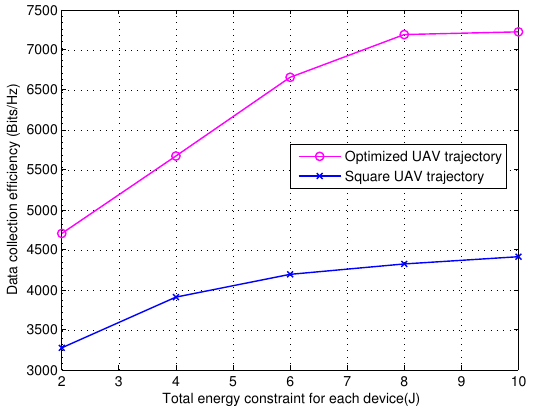
Figure 3. Comparison of data collection efficiency versus total energy constraint of each device for the optimized trajectory and square deployment, both with the aid of the incremental beam selection and iterative algorithm.